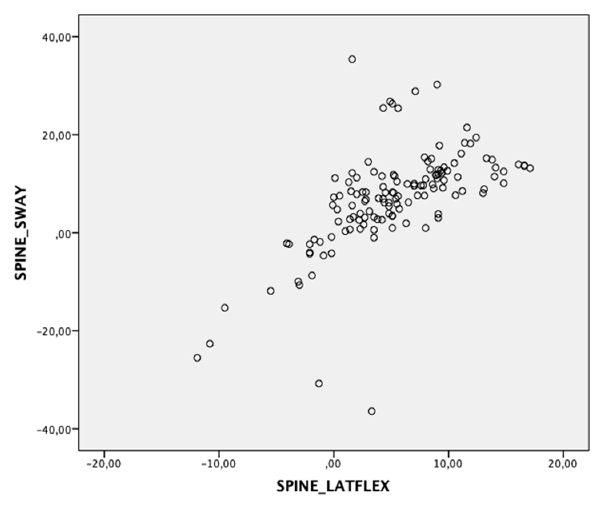
Figure 4. Correlation plots of movement directions tested. (Please note all decimals presented to be read as “.” instead of